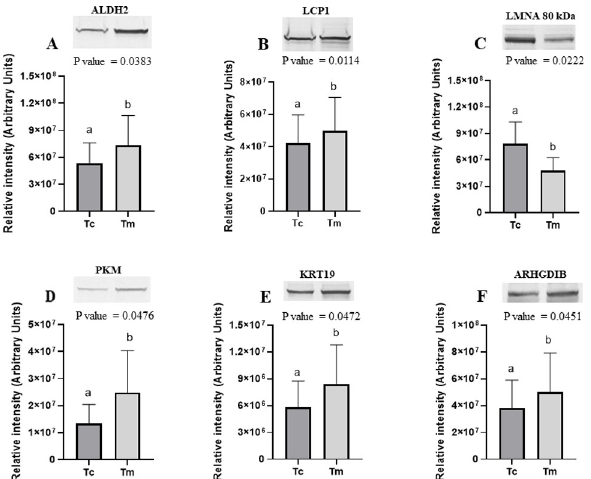
Fig 3. Immunoblotting verification of (A) mitochondrial aldehyde dehydrogenase 2 (ALDH2), (B) plastin (LCP1), (C) lamin 80 kDa (LMNA80 kDa) between center (Tc) and margin (Tm) of ADC tumor lung cancer and (D) pyruvate kinase PKM (PKM), (E) 40-kDa keratin (KRT19) and (F) rho GDP-dissociation inhibitor (ARHGDIB) between Tc and Tm of SCC tumor lung cancer. Results are expressed as means ± SD. Representative blots for one patient are shown. Asterisks indicate significant differences between Tc and Tm of tumor lung cancer (p <